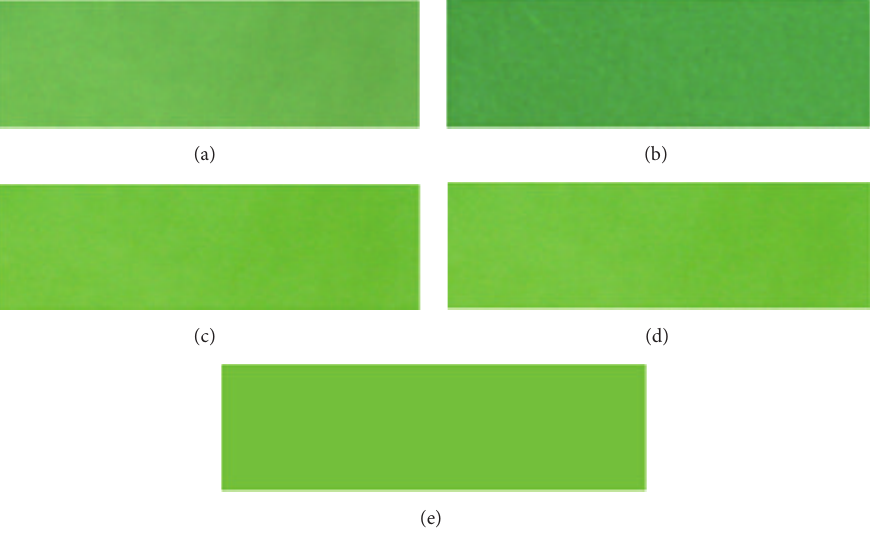
Figure 6: The comparison of 368 M color patches. (a) Before calibration under D65 illuminator and (b) before calibration under LED illuminator and (c) obtained by Φ RGB → sRGB ( ad 65) and (d) obtained by Φ RGB → sRGB ( LED ) and (e) theoretical images of standardized tristimulus